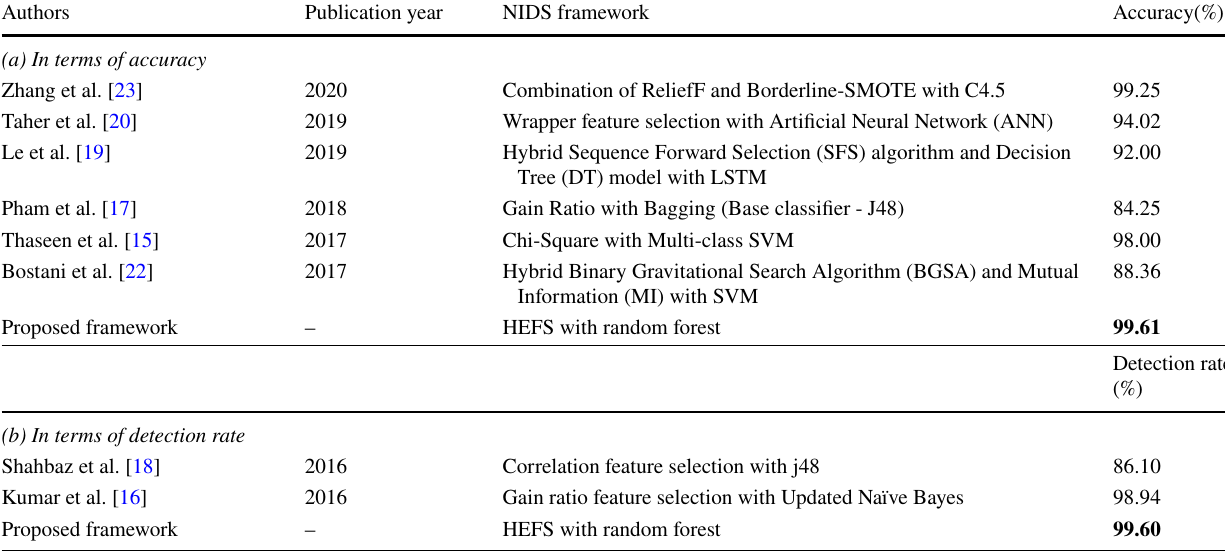
Table 9 Performance comparison of the proposed framework with other NIDS frameworks in terms of accuracy and detection rate